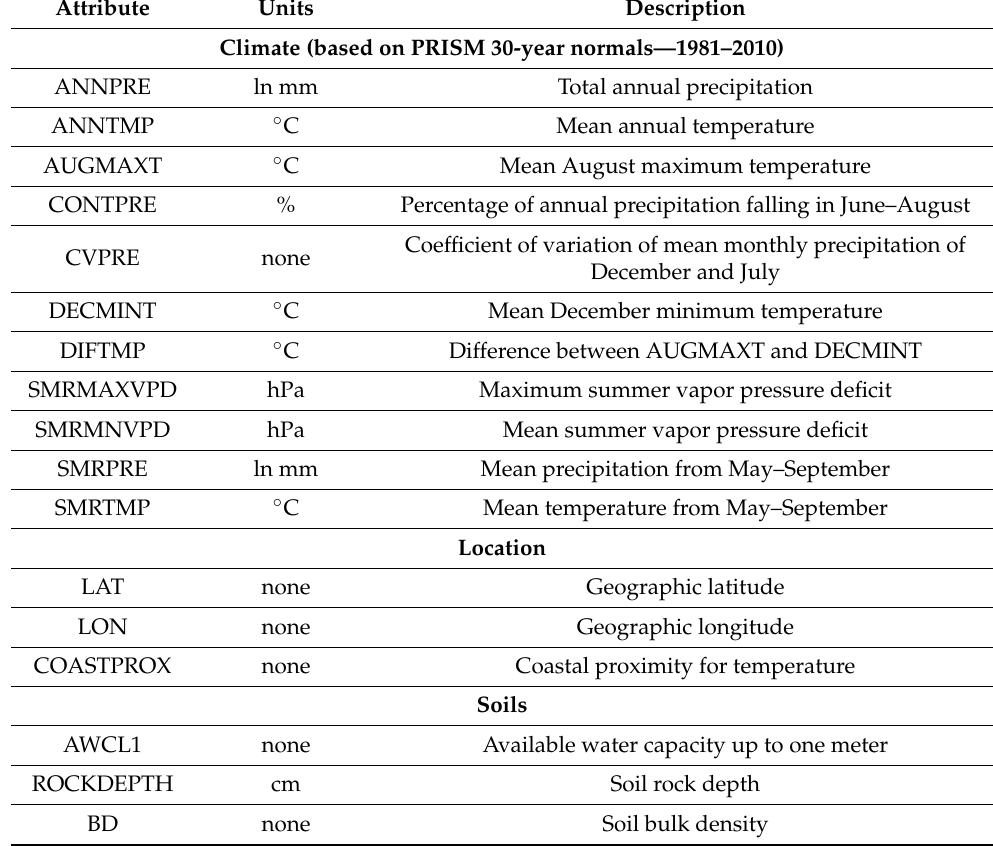
Table 3. Environmental gradients used in